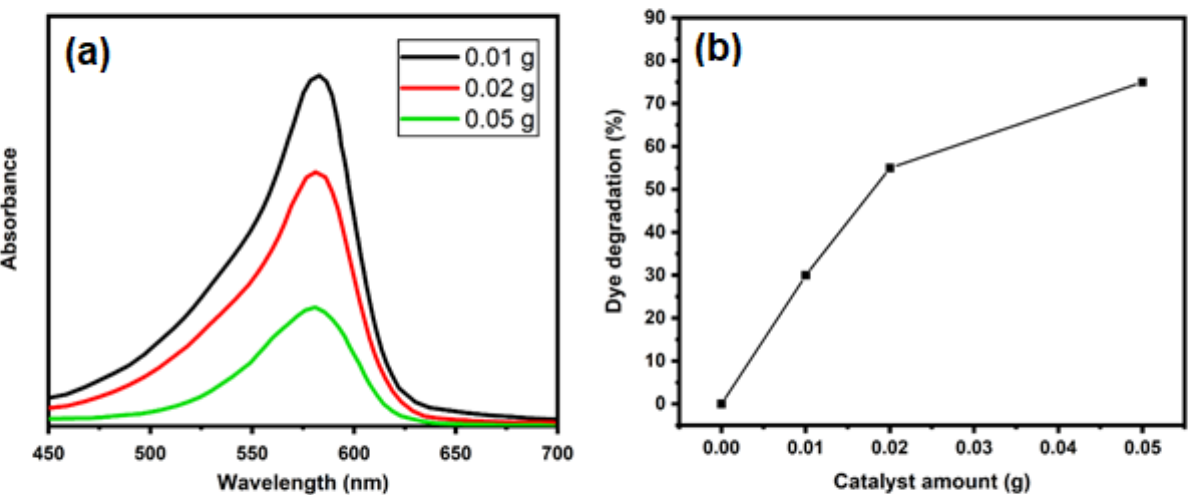
Figure 9. ( a ) Absorption spectra (UV–Vis) of photodegraded bromophenol blue by various concentrations of TiO 2 and, ( b ) their % degradation at various catalyst amounts.